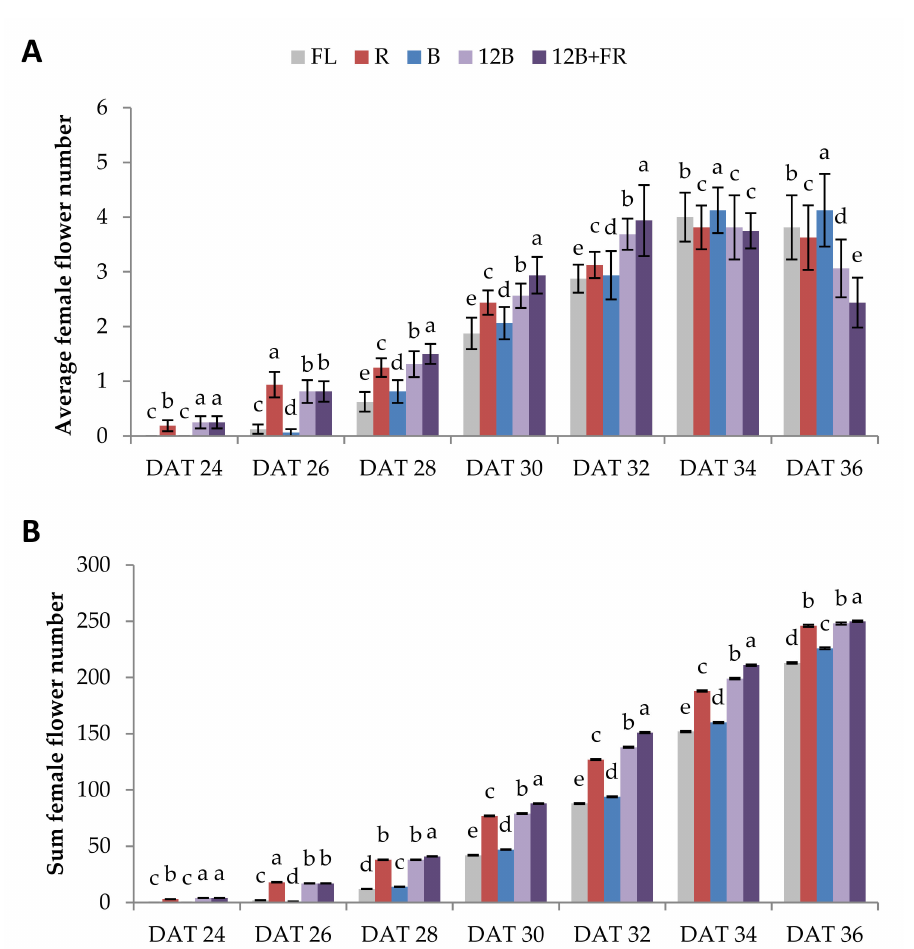
Figure 2. ( A ) Average female flower number on each date and ( B ) sum of female flower number of watermelon plants from the 24th to the 36th day after transplanting in the field. The seedlings were treated for six days in a healing chamber with five light treatments. Mean values ( n = 8; ± SE) within a row followed by different letters are significantly different ( α <